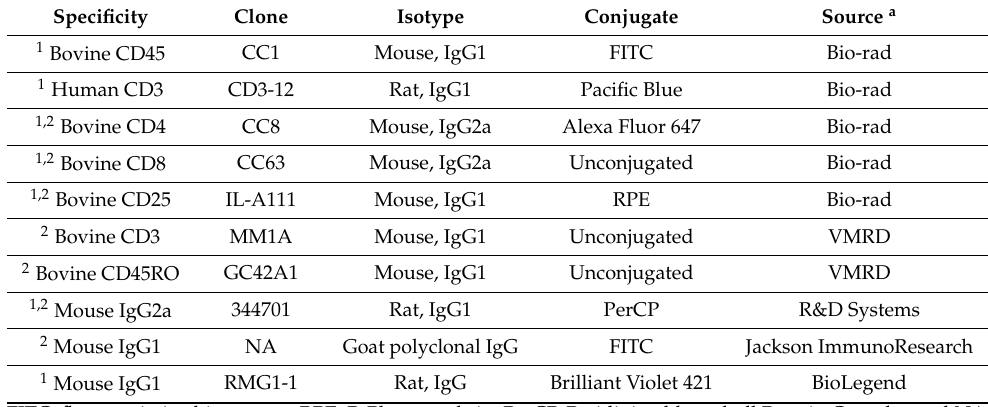
Table 1. Monoclonal antibodies and selected fluorochrome used in the current study.